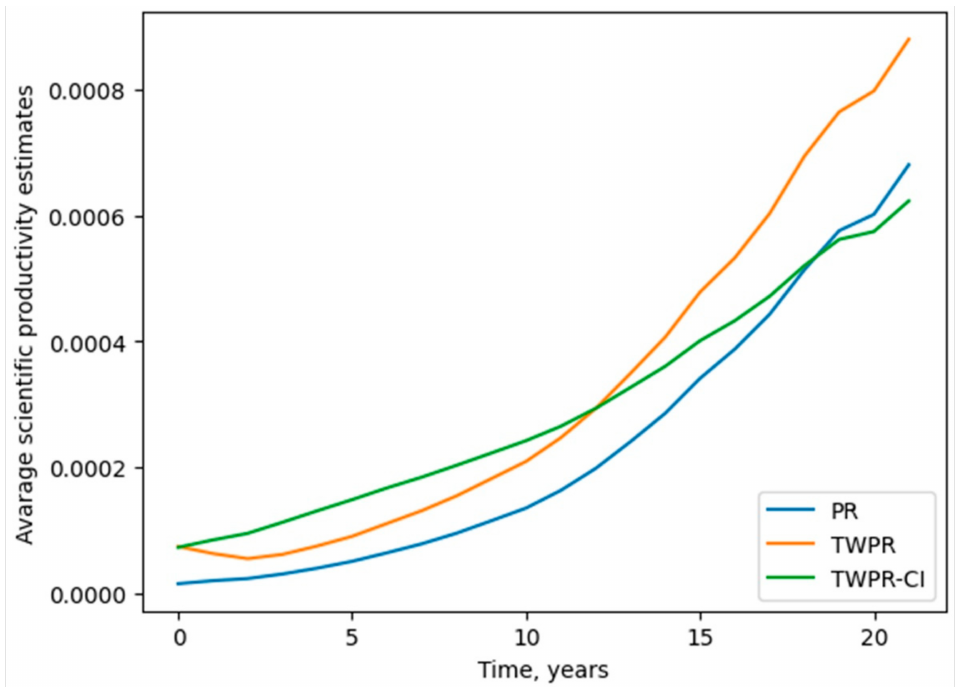
Figure 3. Graph of comparison of scientific productivity estimates of collective subjects belonging to class N according to PR (6), TWPR (6), (8), β = 0, TWPR-CI (6), (8), β = 1